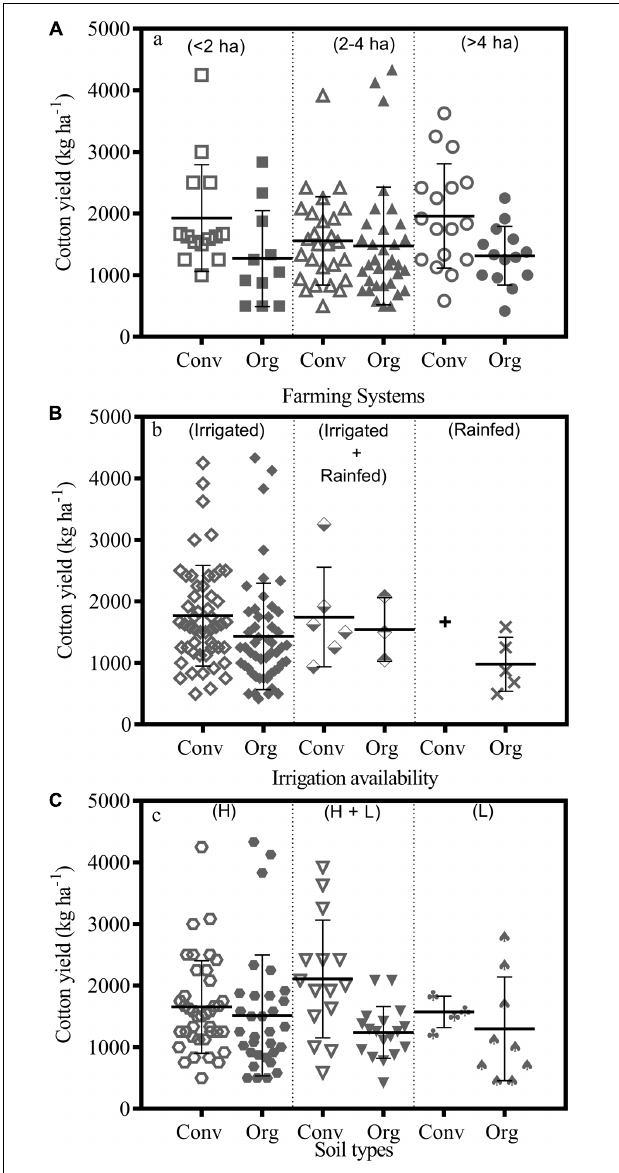
FIGURE 3 | Cotton yield of conventional (Conv) – open circles – and organic farms (Org) – closed circles – in relation to (A) farm size, (B) irrigation availability, and (C) soil types, where each circles represent the reported averaged cotton yield for last 3 years; H: Heavy cotton soil (Vertisol); L: Light soil (Inceptisols and